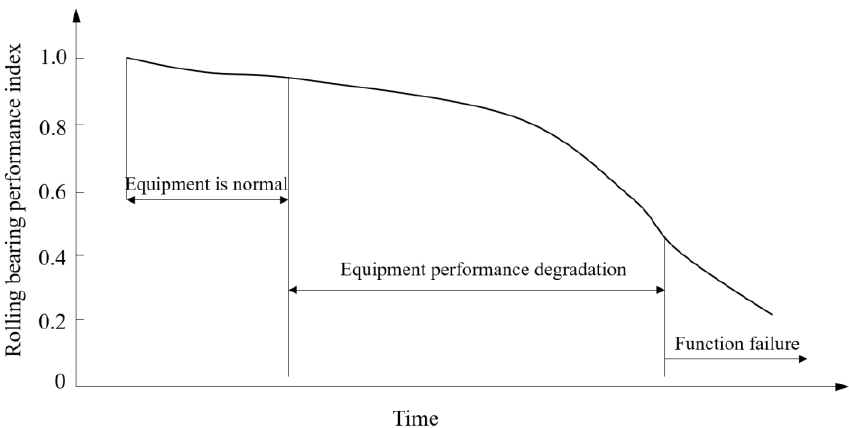
Figure 2. Curve diagram of the degradation state change of the bearings .